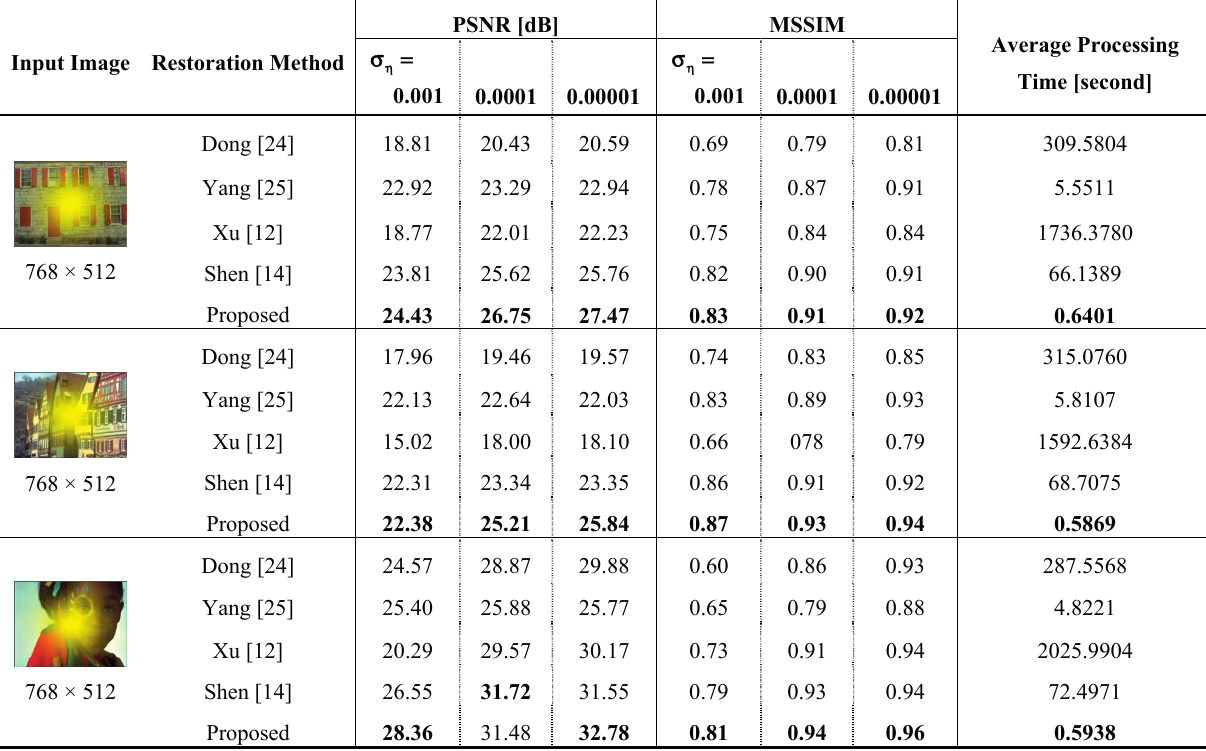
Table 1. Comparison of restoration performance and processing time for three test images, where the center region is blurred by Gaussian with 3.0 σ = , and the peripheral region is blurred with 0.8 σ = .